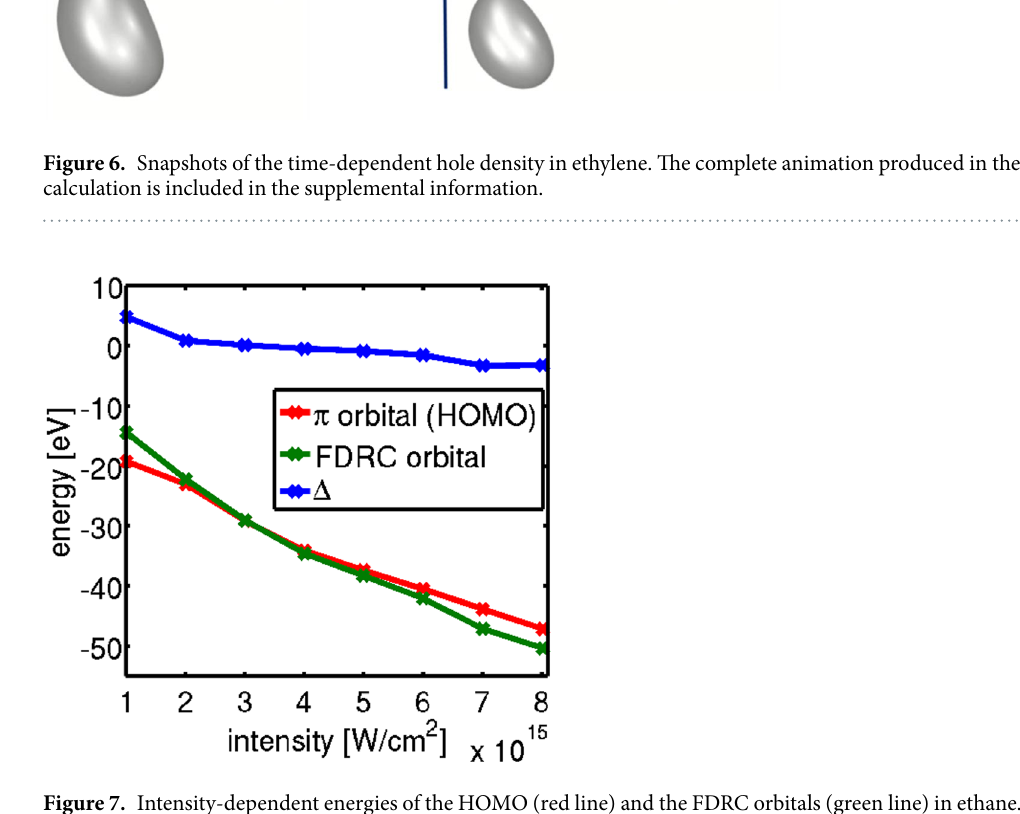
Figure 7. Intensity-dependent energies of the HOMO (red line) and the FDRC orbitals (green line) in ethane. The laser polarization is along a C-H bond for the most noticeable effect. Δ represents the difference in energy between these orbitals as a function of intensity and is shown by the blue